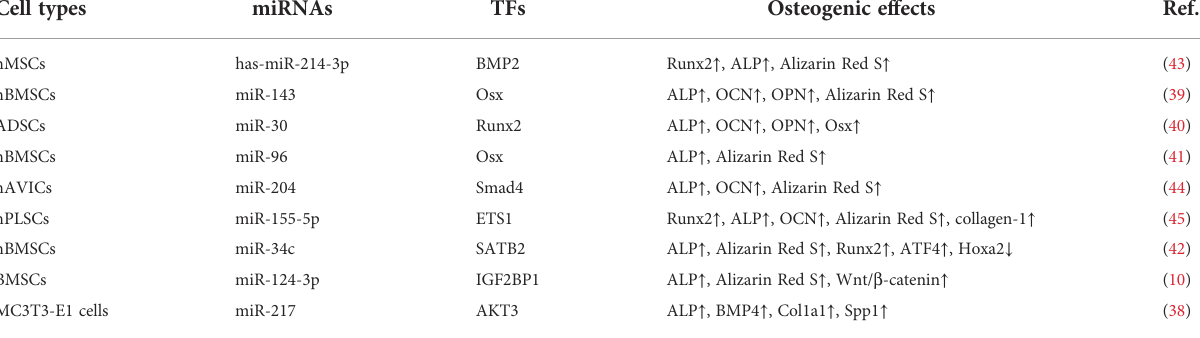
TABLE 1 MALAT1 promotes osteogenic differentiation by activating transcriptional factors (TFs) through interacting with miRNAs. Cell